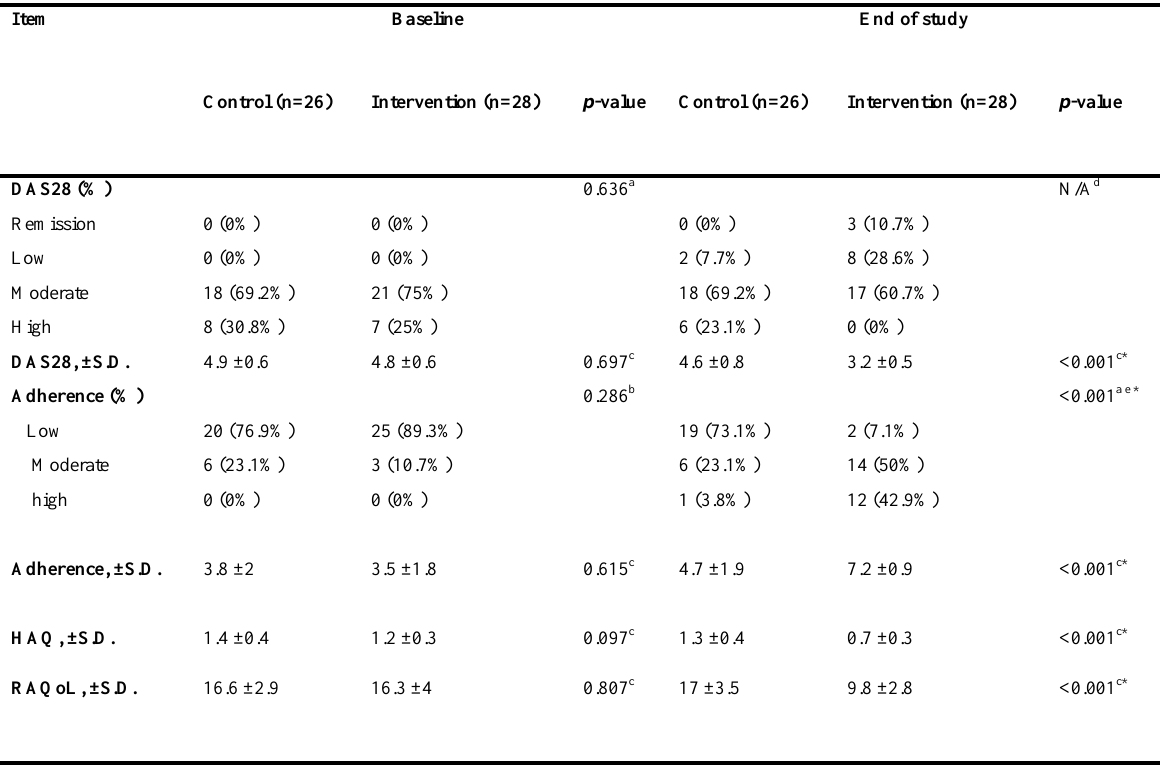
Table 5. Results of the assessment of disease activity, medication adherence, functional disability, and quality of life among the studied groups at baseline compared to the end of the study